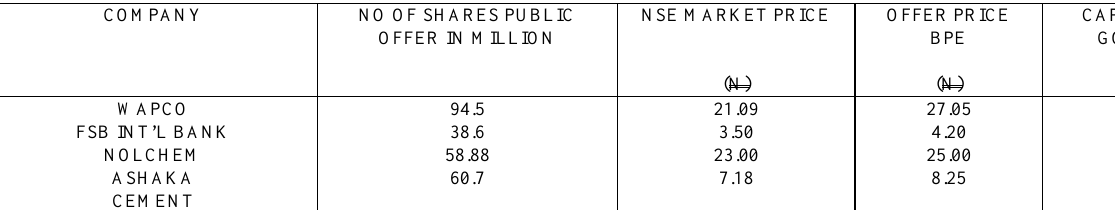
TABLE 3: STOCK PRICING (First Phase) COMPANY NO OF SHARES PUBLIC OFFER IN MILLION